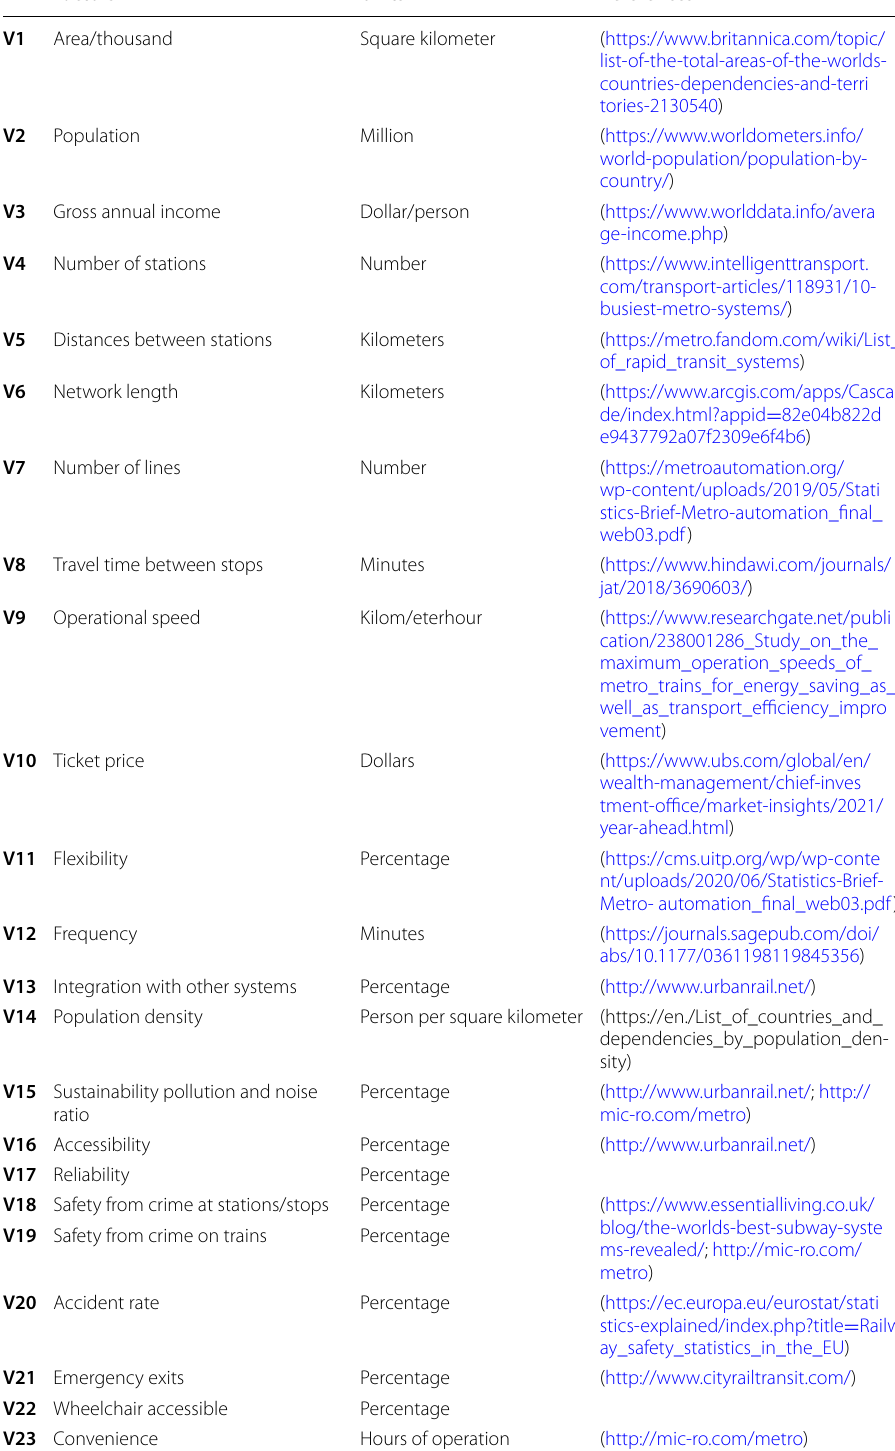
Table 3 Factors improving the performance of the metro system in the study (https:// www. intel ligen ttran sport. com/ trans port‑ artic les/ 118931/ 10‑ busie st‑ metro‑ syste